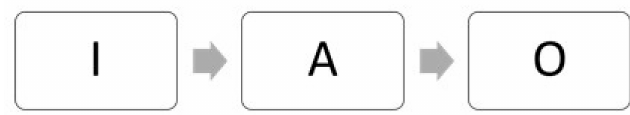
Figure 1. Traditional government information process. Source: Based on the production model of performance (Van Dooren et al.